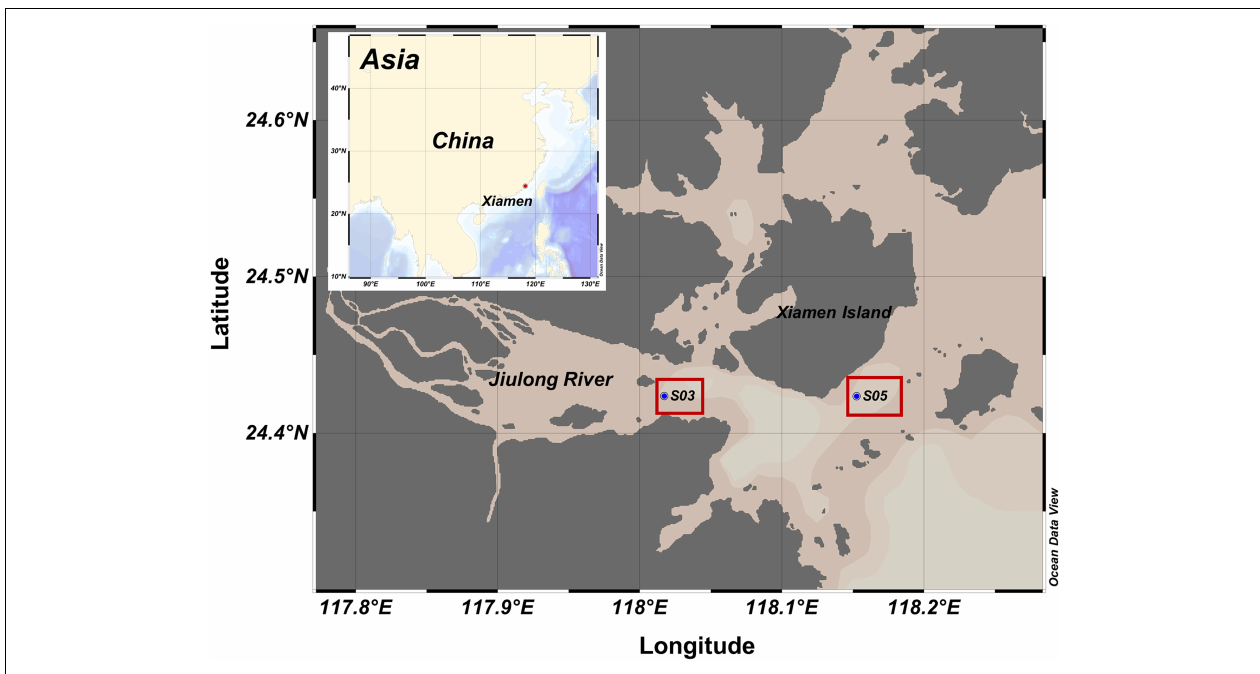
FIGURE 1 | Sampling locations (station S03 and S05) around Xiamen Island, China.